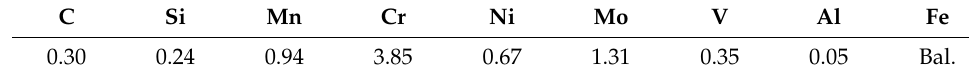
Table 1. Chemical component of 30Cr4MoNiV ultra-high-strength steel (wt.%). C Si Mn